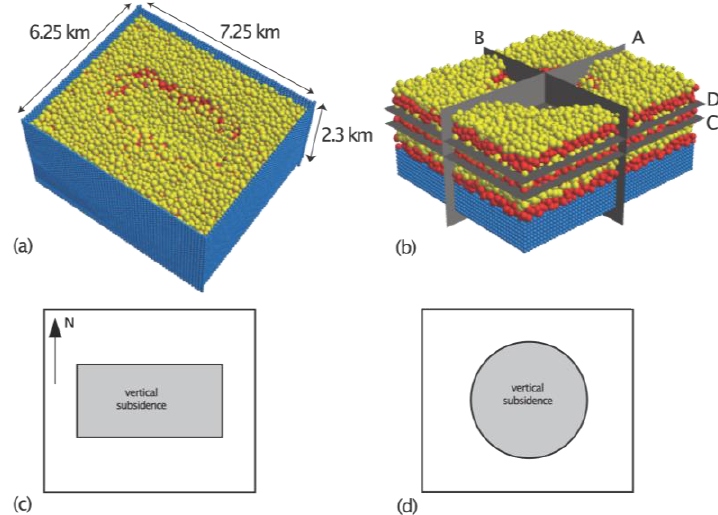
Figure 2. ( a ) Model setup showing dimensions; ( b ) The four model sections discussed in the text: section A runs W–E parallel to the long (7.25 km) model boundary, while section B runs N–S; ( c , d ) Bases of the models in the two experiments with a rectangular and a cylindrical piston, respectively.